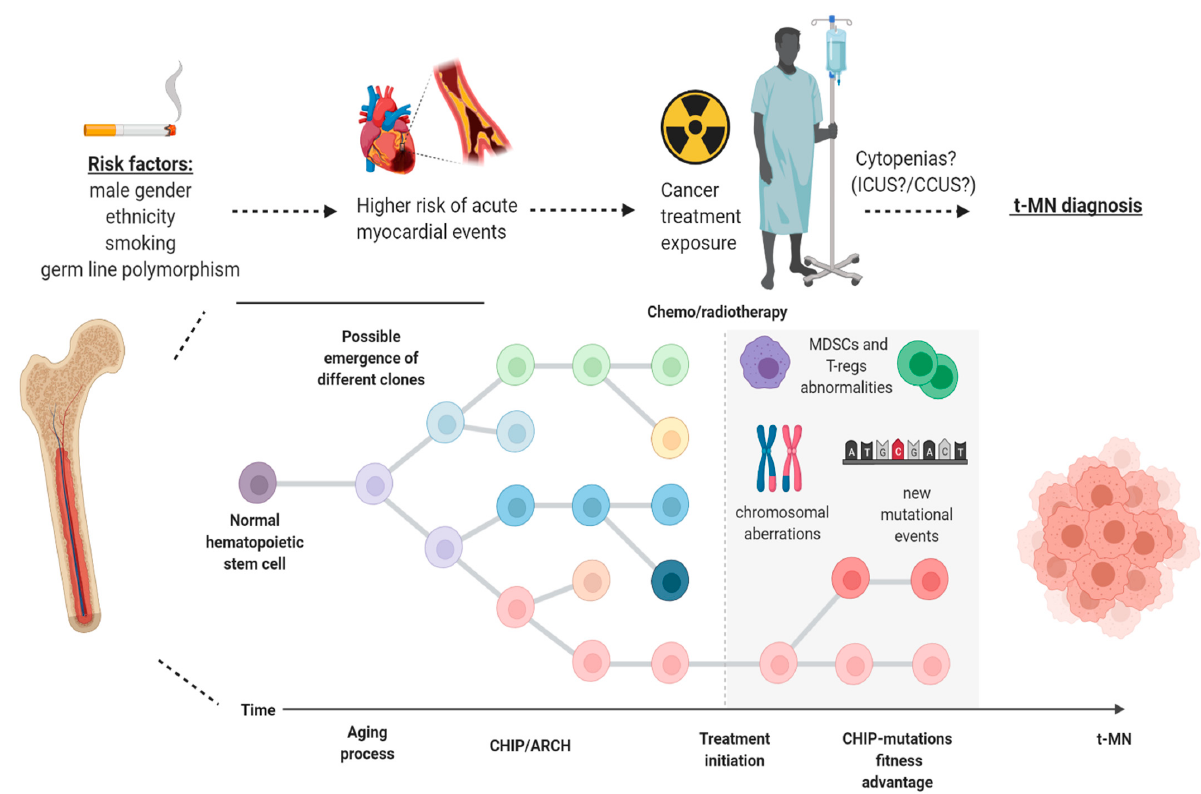
Figure 2. Model of progression of clonal hematopoiesis in patients with cancer undergoing treatment. Different risk factors (gender, cigarette smoking, ethnicity and germ-line mutations) may be at play, giving rise to clonal hematopoiesis of indeterminate potential (CHIP) in healthy individuals within the scenario of age-related clonal hematopoiesis (ARCH). After exposure to chemo-/radiotherapy, particular clones may have a fitness advantage over normal hematopoietic stem cells and, later on, through a stepwise process which may encompass the acquisition of new mutations, copy number alterations and MDSCs/T-regs abnormalities, can be responsible for the development of therapy-related myeloid neoplasms (t-MN). ICUS: idiopathic cytopenia of indeterminate potential; CCUS: clonal cytopenia of indeterminate potential; T-regs: regulatory T cells; MDSCs: myeloid-derived suppressor cells. Image was generated using BioRender.